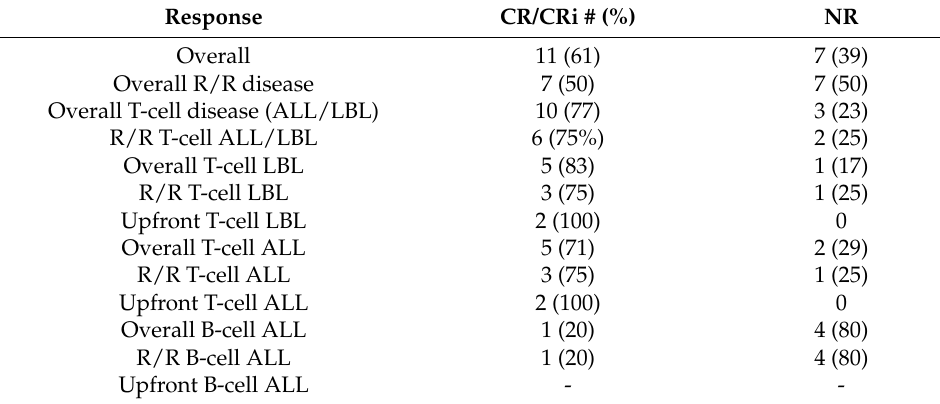
Table 4. Summary of patient response to venetoclax combination therapy.